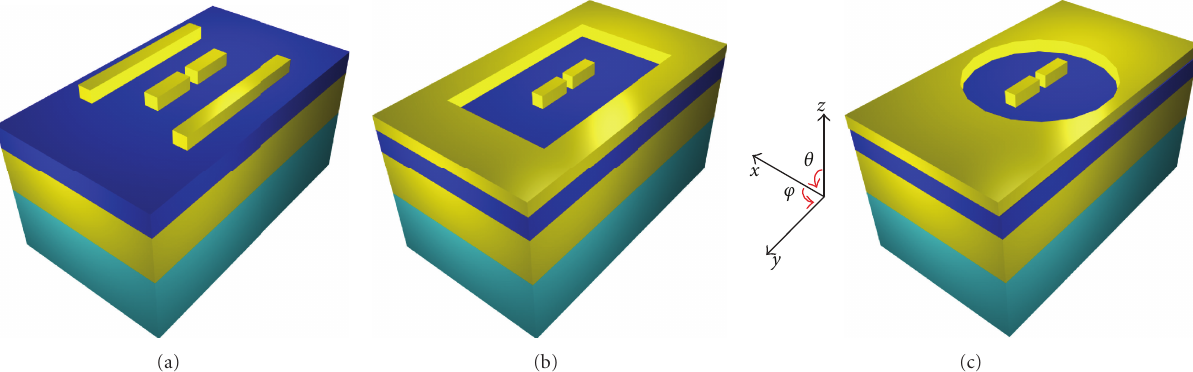
Figure 2: (a) Dipole antenna over ground with two parasitic reflectors 150 nm long and 100 nm from the feed element. (b) Dipole antenna over ground plane with a square reflector of length 500nm (square waveguide antenna). (c) Dipole antenna over ground plane with a circular reflector of radius 250 nm (circular waveguide antenna).